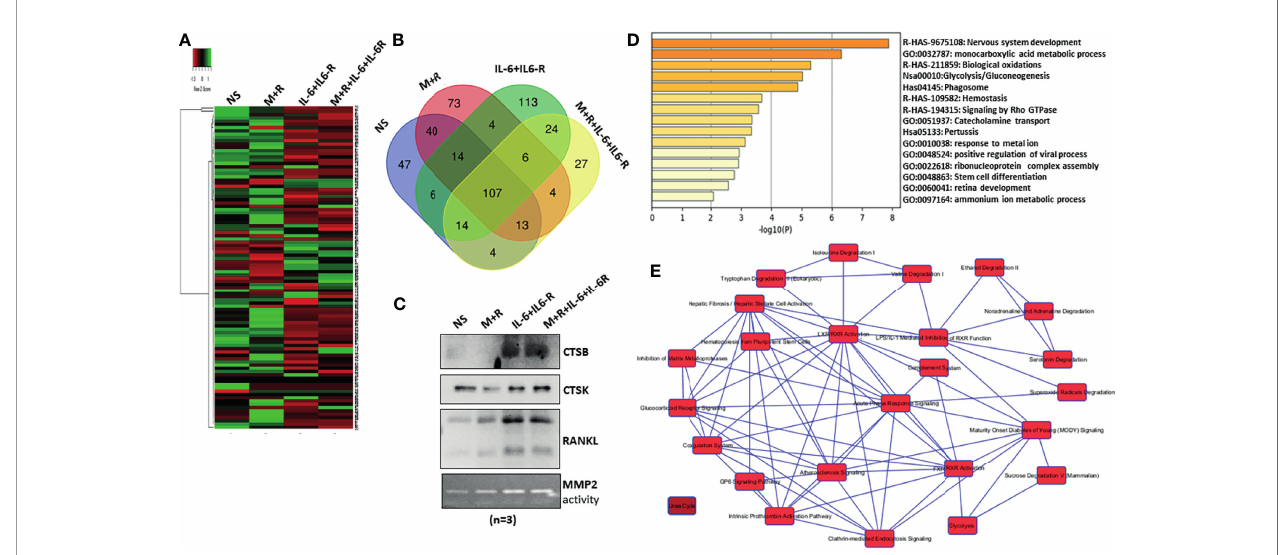
FIGURE 3 | MS-MS analysis of conditioned media identi fi ed uniquely expressed protein by IL-6/IL-6R treatment in human RASFs in vitro . (A) Conditioned media from four RASF donor cells treated with M-CSF/RANKL, IL-6/IL-6R, and M-CSF/RANKL plus IL-6/IL-6R (All) for 12 days were subjected to untargeted proteomics, which revealed 107 common proteins with differential expression. (B) Venn diagram shows the number of common and unique secretory proteins identi fi ed through untargeted proteomics in RASFs. (C) Increased secretion of CTSB, CTSK, and RANKL by transformed RASFs was con fi rmed through Western blotting of the conditioned media from the treated RASFs. (D) Cellular pathway changes brought about by chronic exposure of IL-6+IL-6 R in RASFs were analyzed using Metascape Gene Ontology studies, and (E) network analysis using ingenuity pathway analysis which predicted metabolic reprogramming in